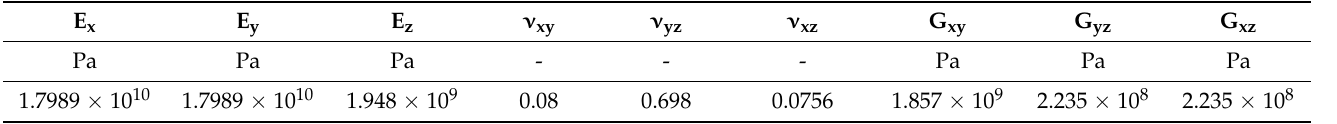
Table 4. Material constants for the laminate (E, Young’s modulus; ν , Poisson’s ratio; G, Kirchhoff’s modulus)